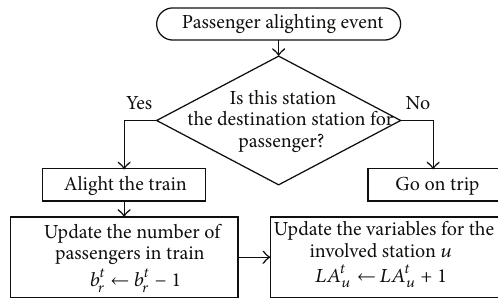
Figure 6: Flowchart of passenger alighting event.